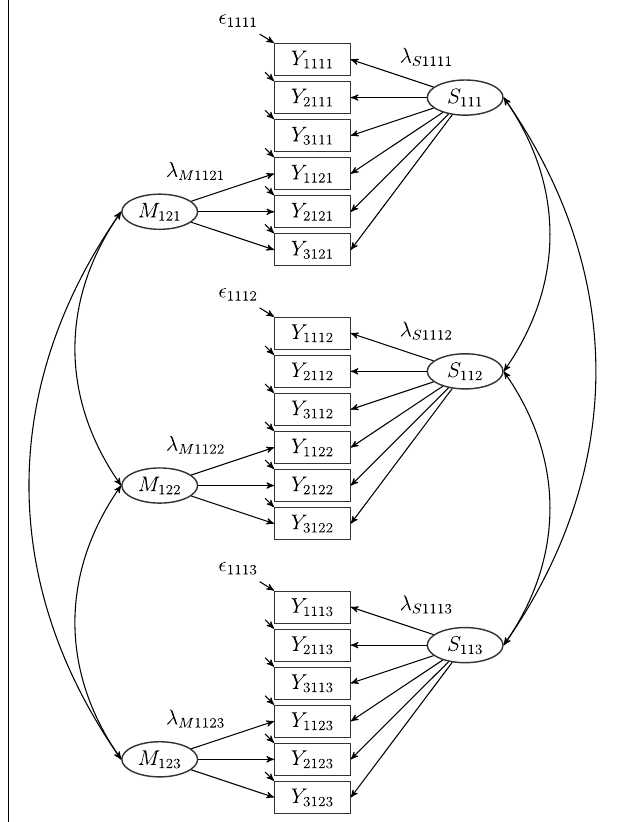
FIGURE 2 | A latent correlated state correlated method minus one [CS-( M − 1)] model with three indicators ( i = 3), one construct ( j = 1), two methods ( k = 2) and three occasions of measurement ( l = 3), where Y ijkl : observed variables, S jkl : latent state factors, λ Sijkl : state factor loadings, M jkl : latent method factors, λ Mijkl : method factor loadings, (cid:3) ijkl : measurement error variables. Intercepts ( α ijkl ) are not depicted in the